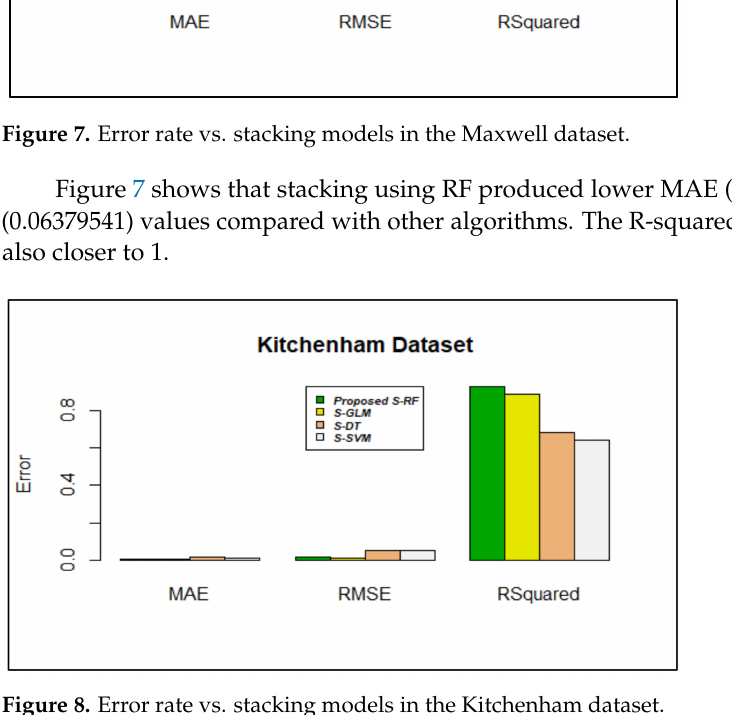
Figure 8. Error rate vs. stacking models in the Kitchenham